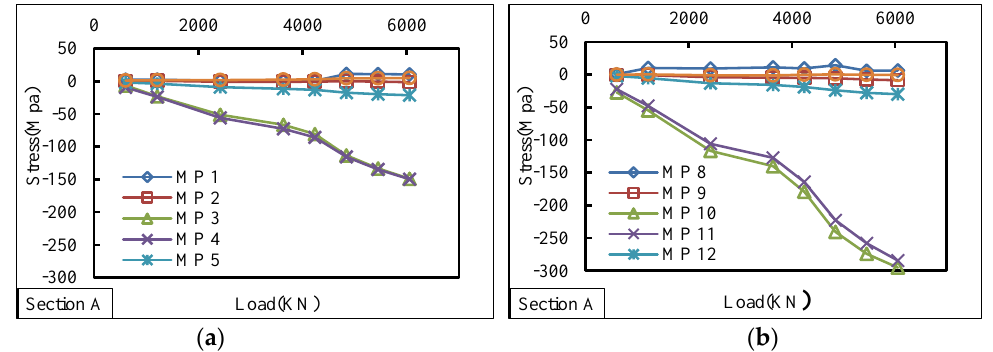
Figure 11. The relationship between load and stress of the steel bars on the top slab specimen: ( a ) the upper layer steel of Section A-A; and ( b ) the bottom layer steel of Section A-A. MP, measuring point. The stress level of the steel bars at the upper layer was higher than that at the lower layer at Sections A-A and I-I due to the eccentricity of prestressing tendons (approximately 0.1 m). The tensile and compressive stresses at Section A-A were higher than those of Section I-I, which indicates the stress level of tension section is higher than that of anchorage section. The effect of local bearing pressure is more remarkable at tension